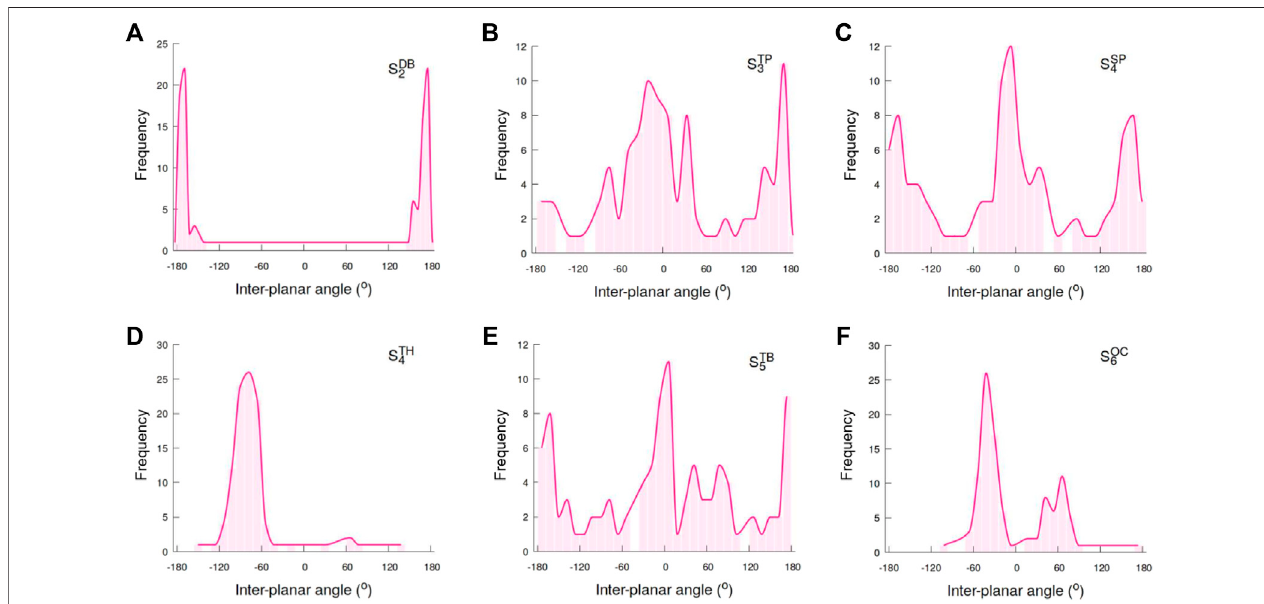
FIGURE 8 | Shown are the distributions of the inter-planar angles in self-assemblies formed by (A) dumbbell, (B) trigonal planar (C) square planar, (D) tetrahedral, (E) trigonal bipyramidal, and (F) octahedral shaped particles.